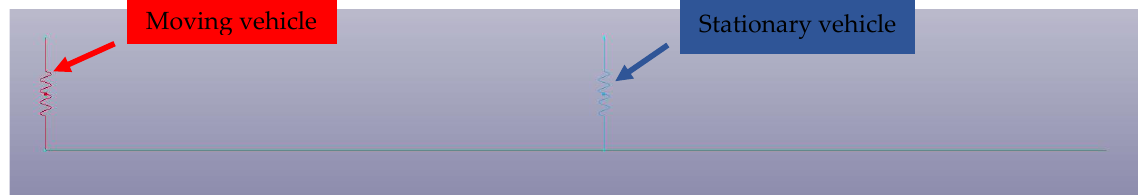
Figure 3. FE model of a bridge with a stationary vehicle parked in the middle and a moving vehicle passing from left to right.